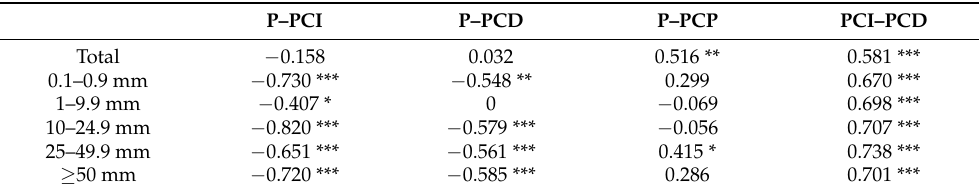
Table 3. The correlation coefficients between the amount of precipitation and the PCI, the amount of precipitation and the PCD, the amount of precipitation and the PCP, and the PCI and PCD for the annual amount of precipitation and each intensity level for the Daning River basin.